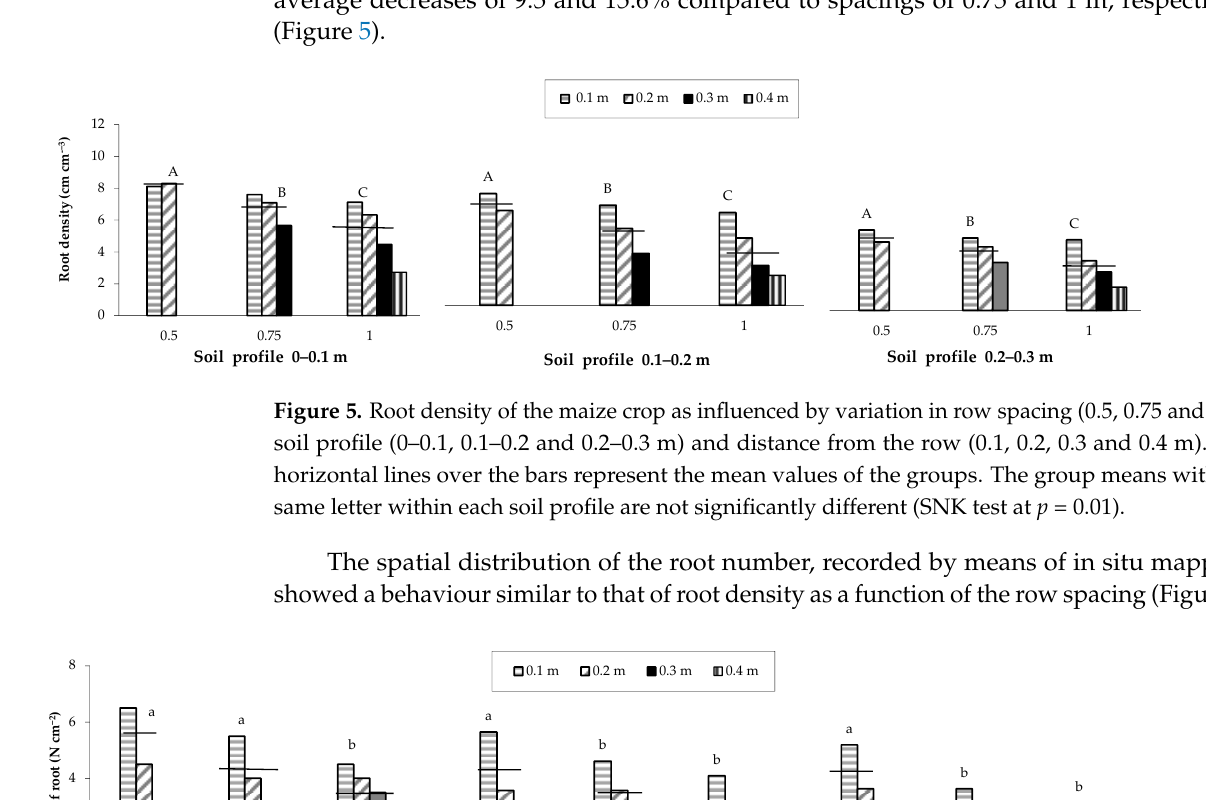
Table 2. Cracking properties in the bare soil and maize-cultivated soil under different row spacings. Treatments